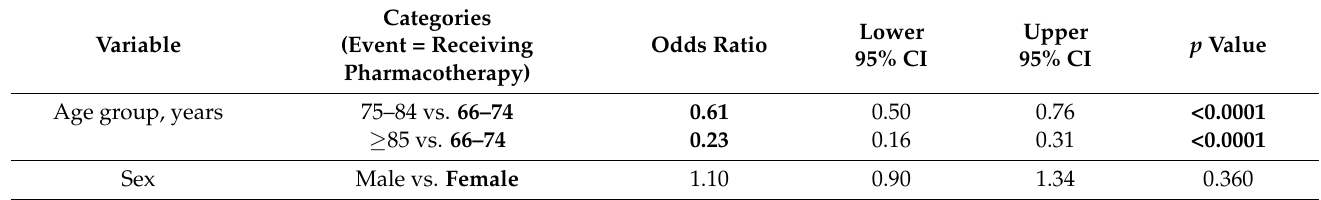
Table 3. Multivariate logistic regression assessing the odds of receiving pharmacotherapy among patients with histologic confirmation